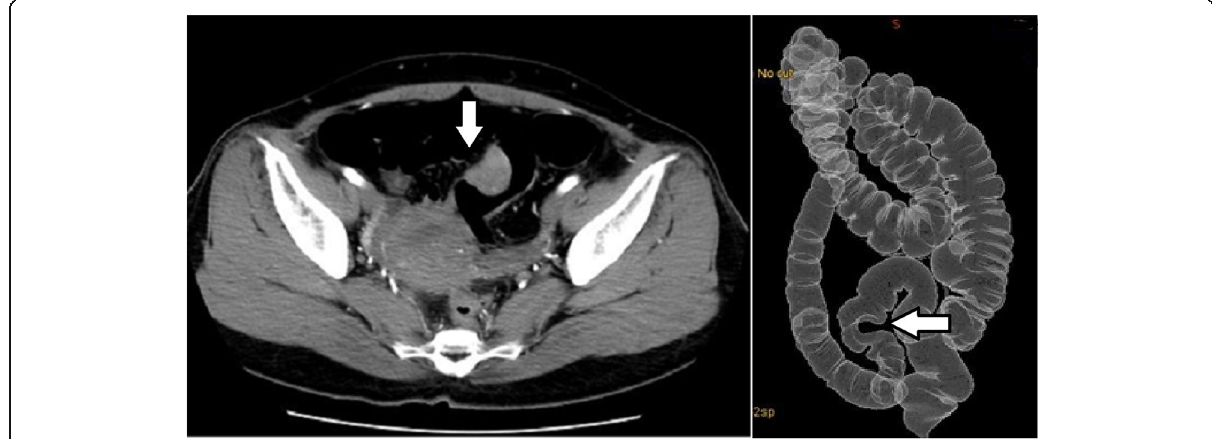
Fig. 2 Computed tomography (CT) reveals the thickened wall of the sigmoid colon (arrow), and CT colonography shows the deformed wall in the sigmoid colon (arrow)